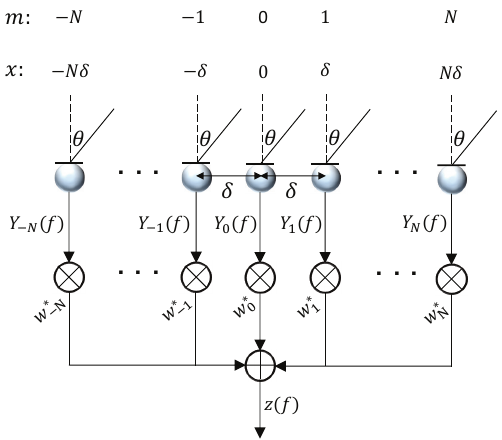
Figure 1. Beamforming with a uniform linear array consisting of M ( M = 2 N + 1 ) microphones with spacing δ , where m denotes the microphone index, x denotes the location of the microphone, θ is the direction of arrival angle measured with respect to the broadside of the linear